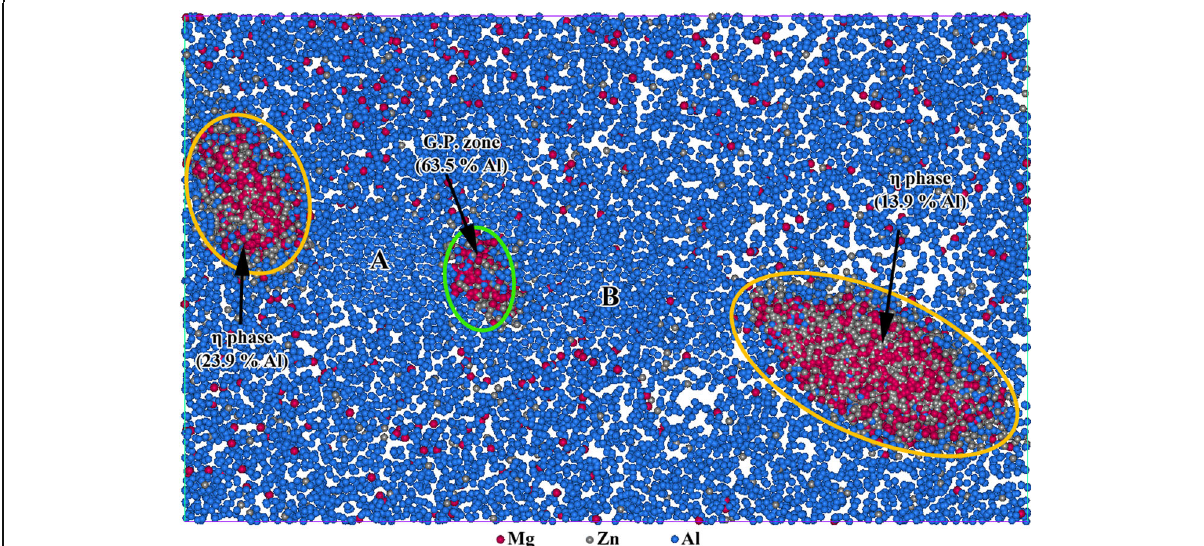
Fig. 6 Typical 1-nm-thick atom map (50 × 30 nm) showing the distribution of Mg, Zn, and Al atoms in OA state. The corresponding Al content within nanoparticles were shown as inset